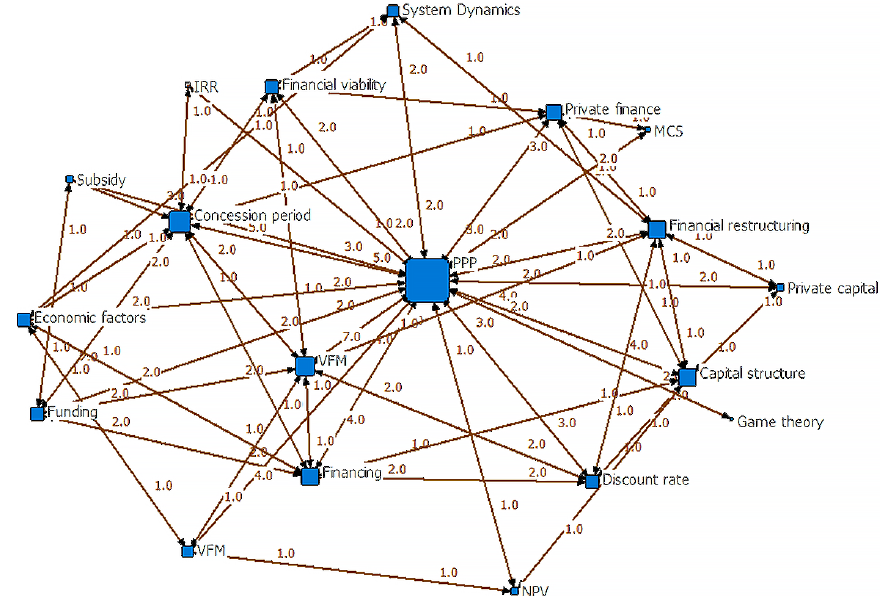
Figure 7. Economic and financial topics in